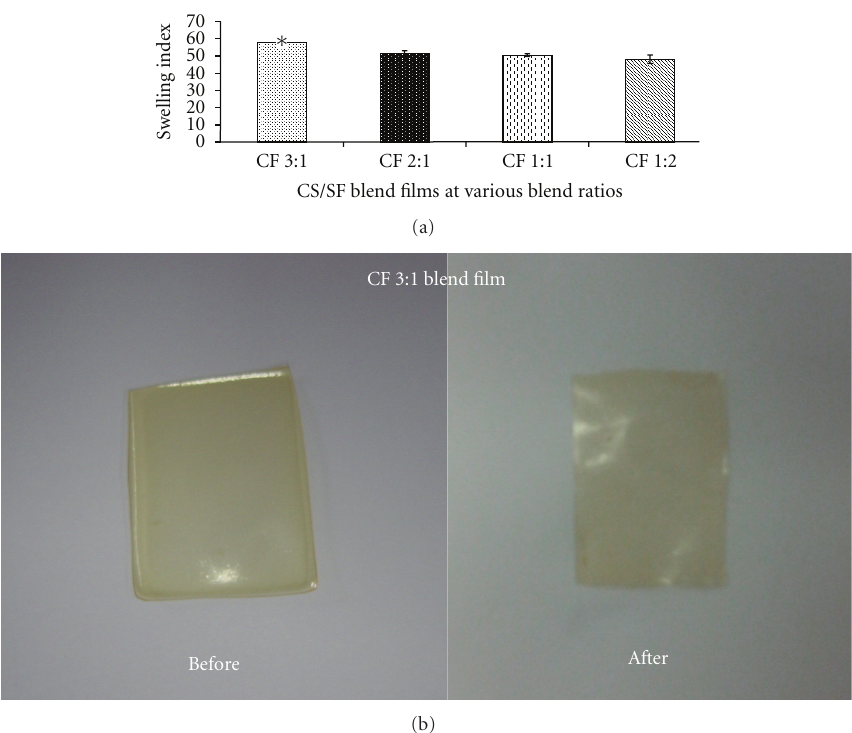
Figure 5: Swelling property and retain ability of CS/SF blend films with various blend ratios of chitosan:fibroin (CF) in PBS (pH 7.4) at 37 ◦ C for 24 h; (a) degree of swelling and (b) morphology. Each bar represents mean ± standard error ( n = 3). One-way ANOVA showed a significant di ff erence in degree of swelling among groups ( ∗ P < 0 .